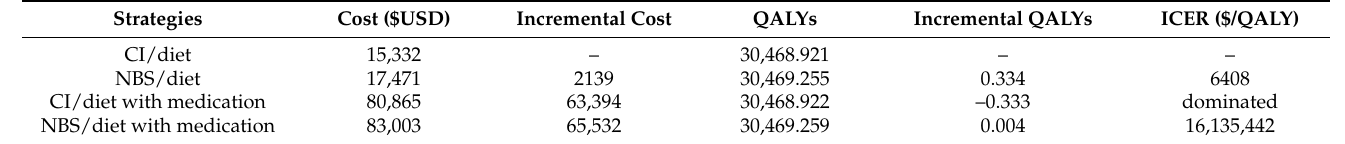
Table 4. Base case results (partial adherence, cohort size: 1000 individuals).